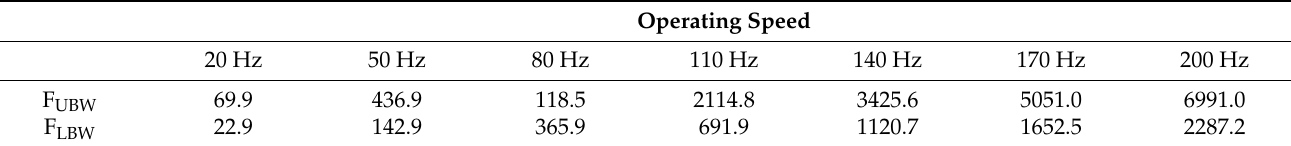
Table 6. External forces of the balance weights according to operating